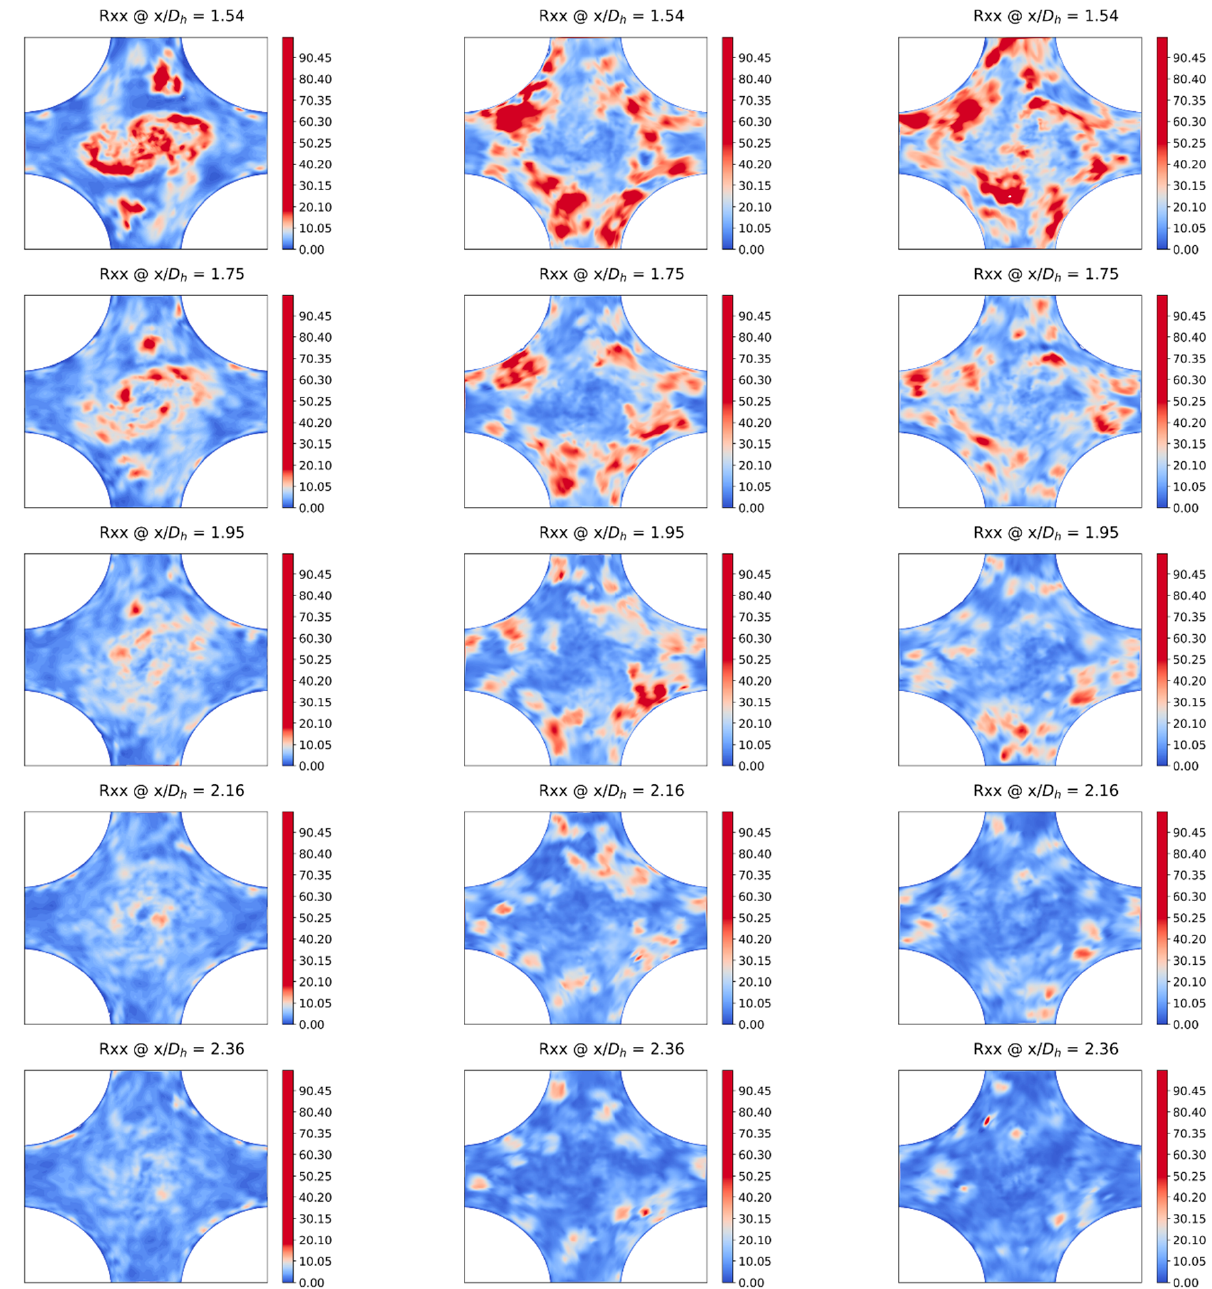
Figure 12. Axial evolution of downstream normalized streamwise component of Reynolds stress for the single-phase ( left ), We40 ( middle ) and We80 ( right ) cases.